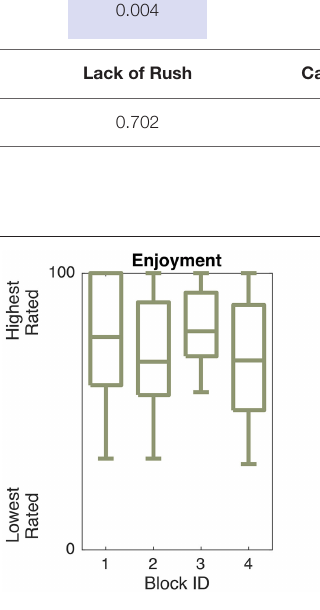
FIGURE 9 | Responses to enjoyment-related survey questions across interaction blocks. No significant differences were found.